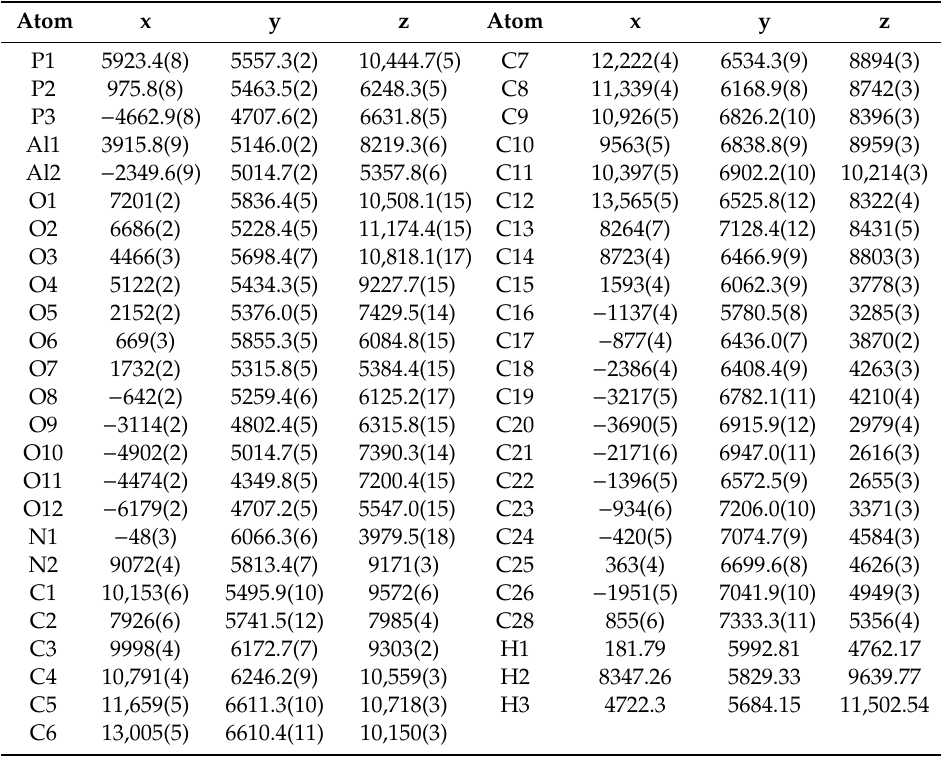
Table 3. Fractional atomic coordinates ( × 10 4 ) of Al, P, O, C, N and selected H and equivalent isotropic displacement parameters (Å 2 × 10 3 ) for SYSU-6. R eq is defined as 1 / 3 of the trace of the orthogonalized U IJ